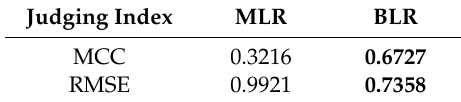
Table 16. Skill scores for the PC2 forecast by di ff erent models (bold font indicates the best